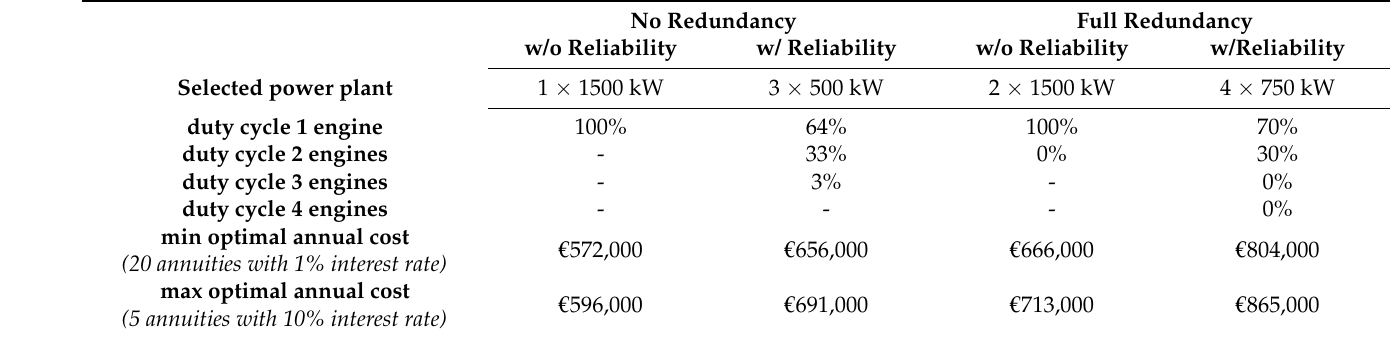
Table 8. Results